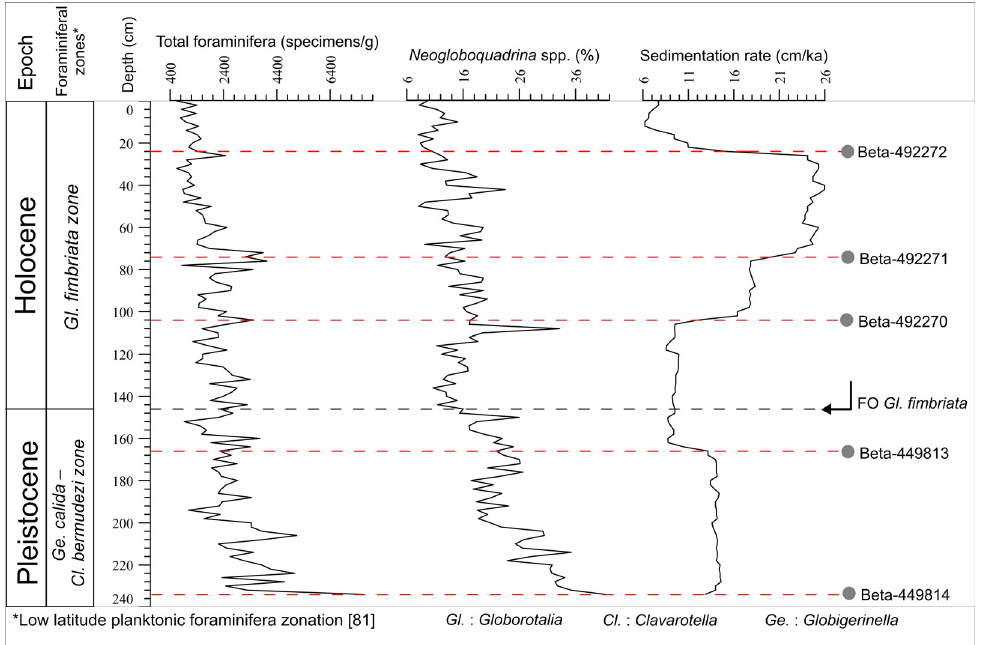
Figure 5. Sedimentation rates obtained from age model (Table S1) and relevant foraminifera data from previous studies on core ST08 (total foraminifera, Neogloboquadrina spp. abundance, and foraminiferal zones) [56,57] (Table S2). Red dashed lines terminated by gray circles indicate the stratigraphic position of AMS 14 C samples. Black dashed line terminated by downwards arrow with tip leftwards indicates the first occurrence (FO) of Gl. fimbriata .